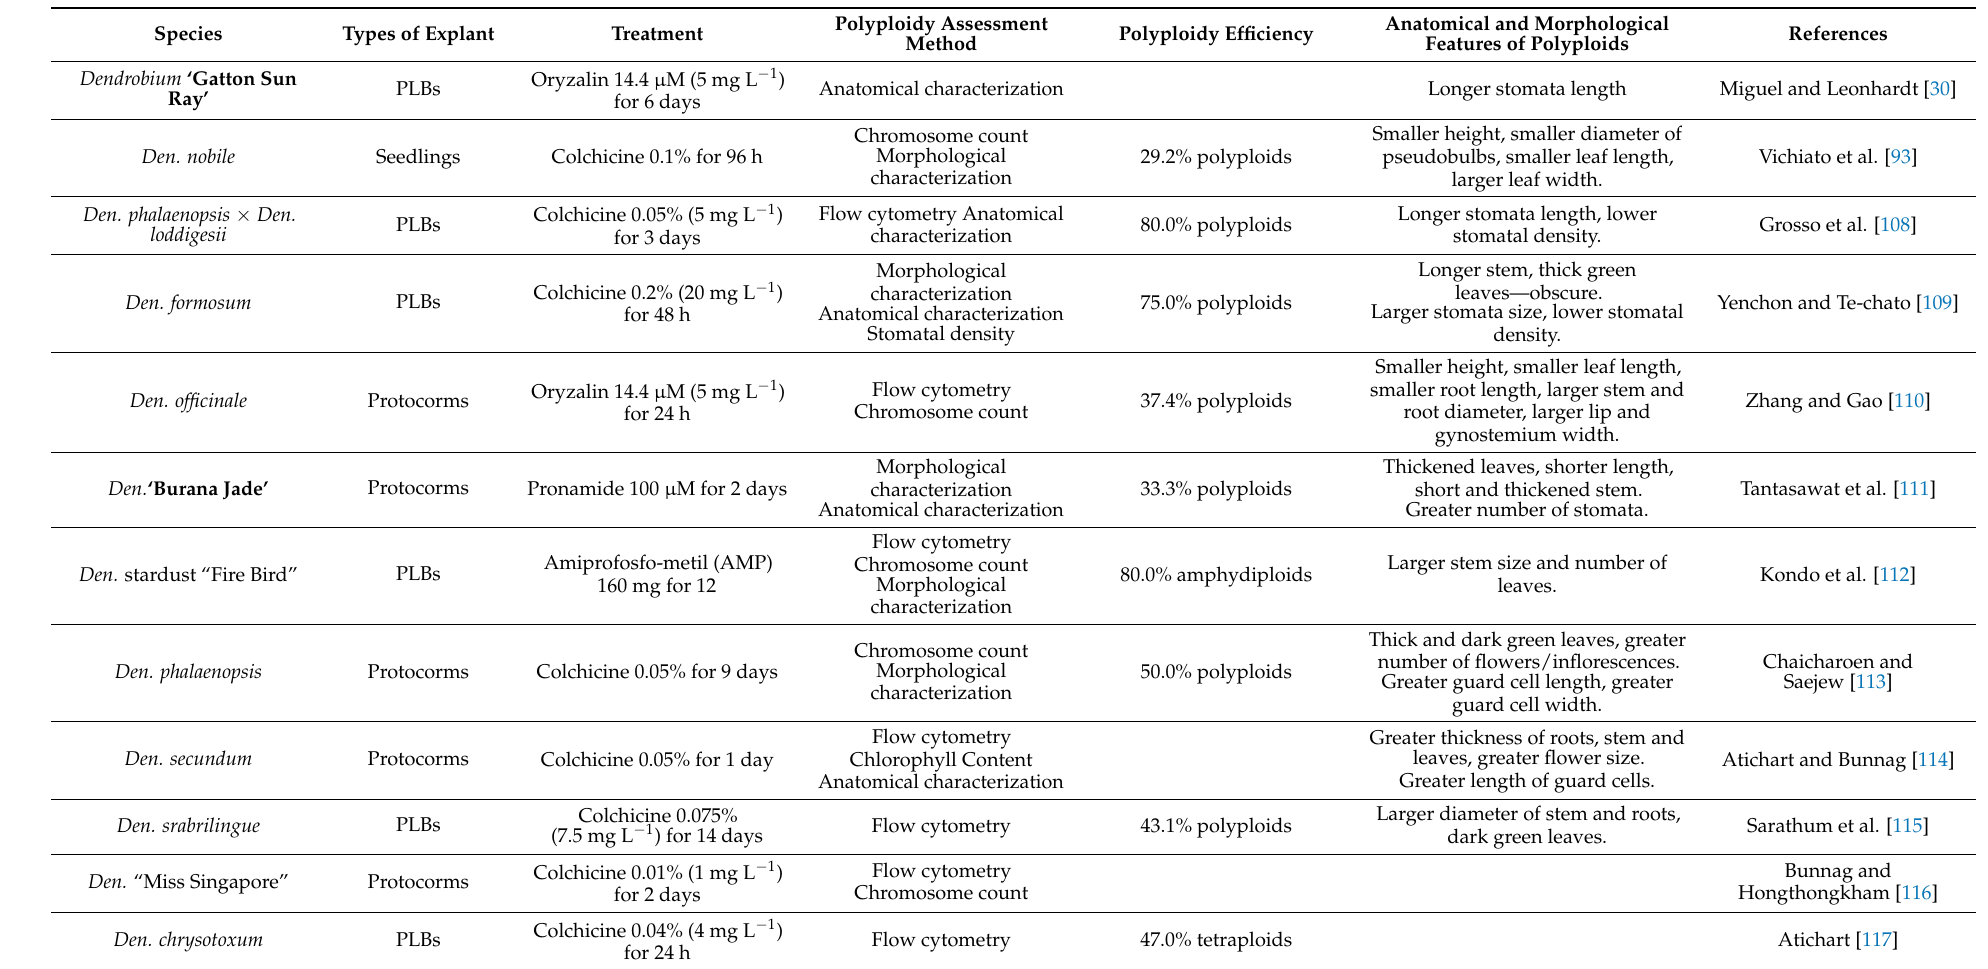
Table 4. Polyploidy induction of Dendrobium using antimitotic